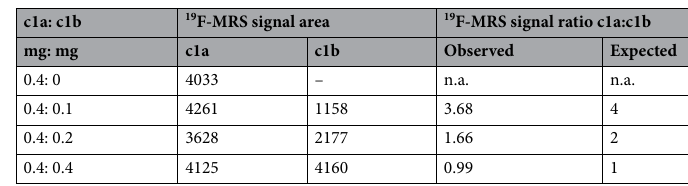
Table 1. Validation of spectral modelling of overlapping 19 F-MRS peaks for c1a and c1b using jMRUI software. The proportions of peak areas of c1a (keto tracer) and c1b (hydroxy metabolite) in blood (4 mL) showed reasonable agreement with the expected ratio. 0.4 mg of c1a in blood was scanned alone and after addition of variable amounts of c1b at near their Limits of Detection (0.1–0.4 mg). Spectra were acquired with 800 repetitions (400 s). Signal areas are in arbitrary units. n.a. = not applicable.